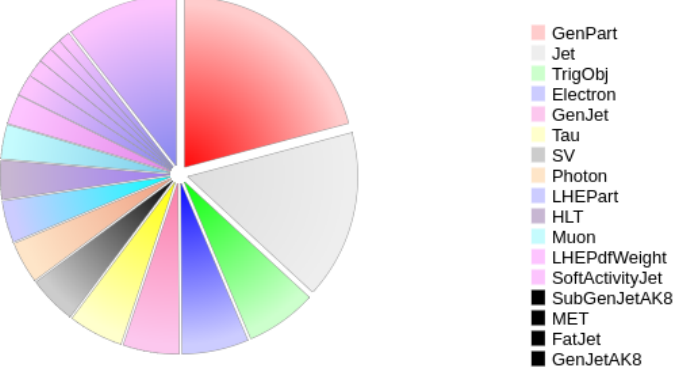
Figure 1. NANOAOD composition in term of relative size used by each object collection, on a simu- lated t ¯ t